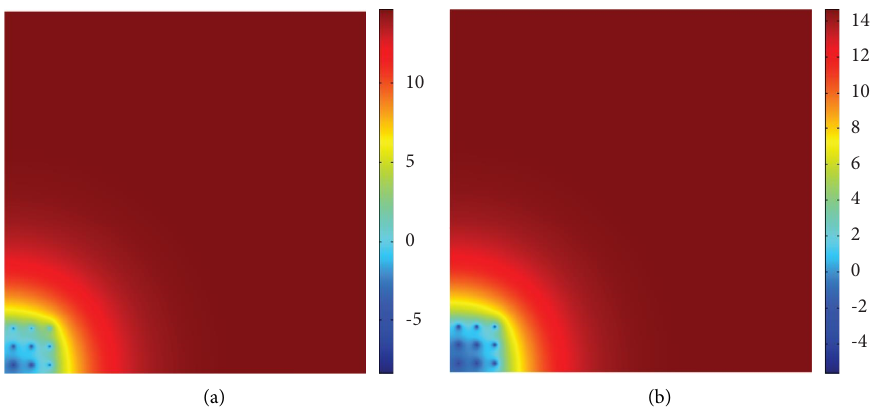
Figure 9: Two diferent working scenarios on day 2400 (7 th year, day 210): (a) same HER and (b) same inlet fuid temperature.